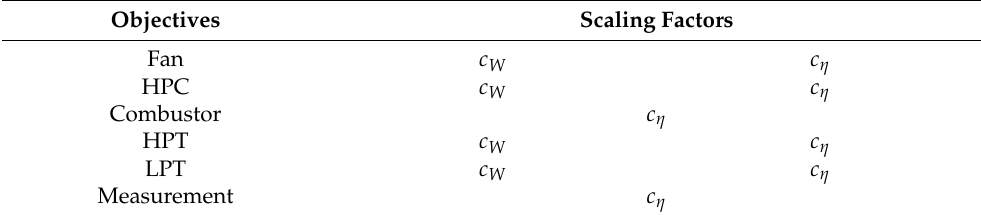
Table 2. List of to-be-calculated scaling